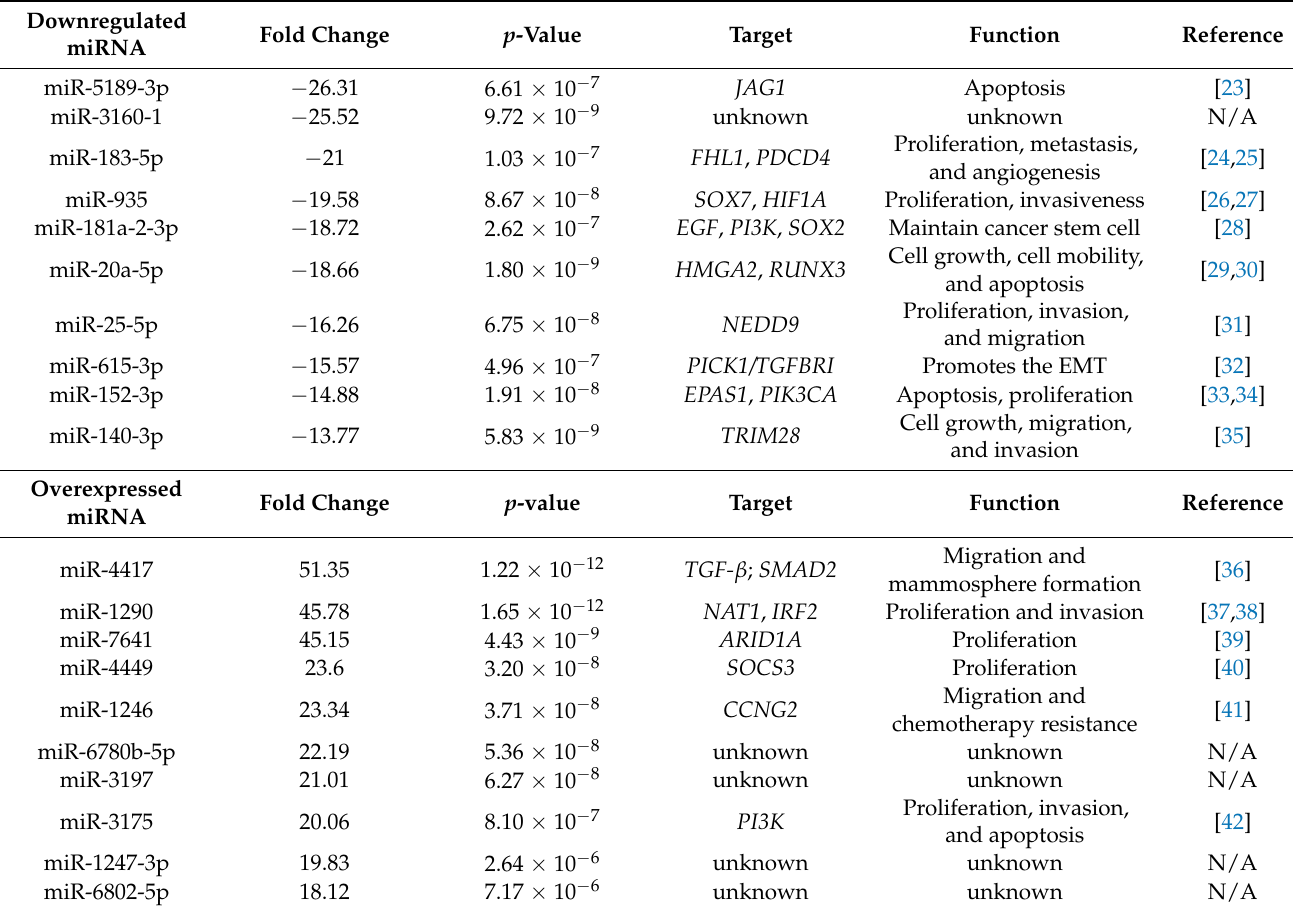
Table 1. Top 10 most downregulated and overexpressed miRNAs in 3D organotypic cultures com- pared to 2D